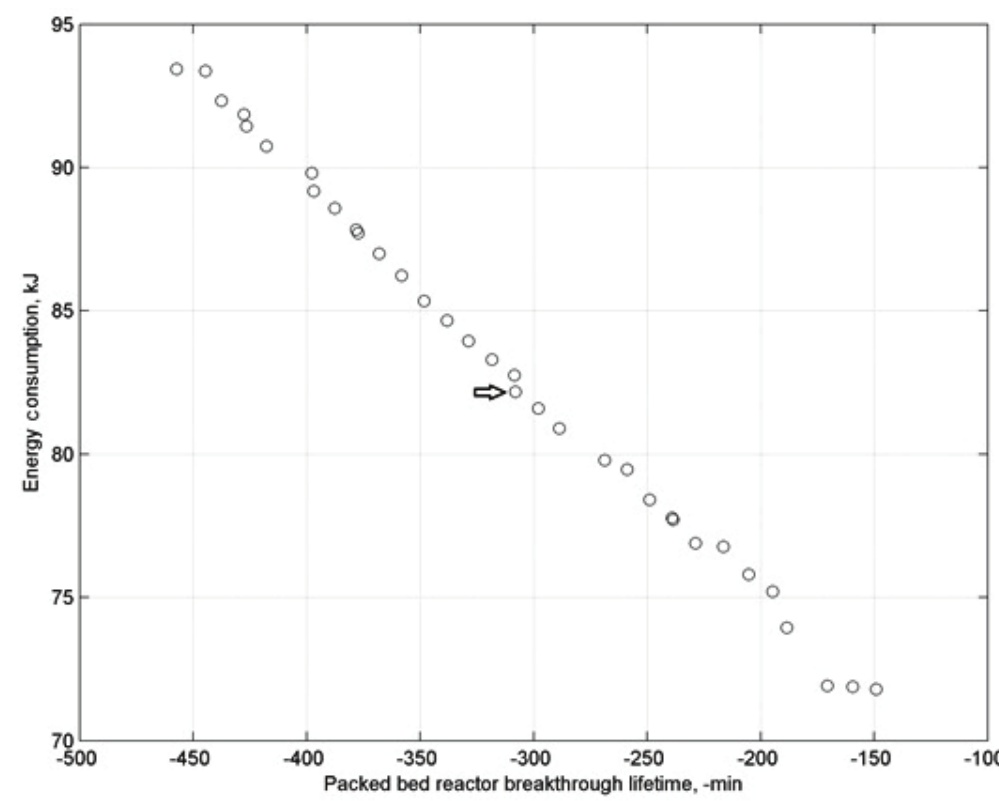
Fig. 9 – Pareto-optimal solutions